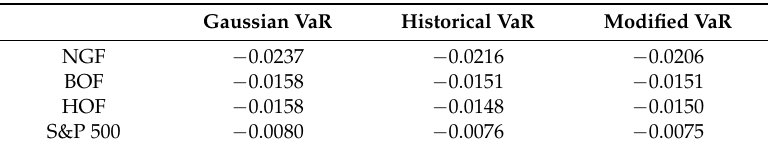
Table 6. VaR Analysis of Variables.